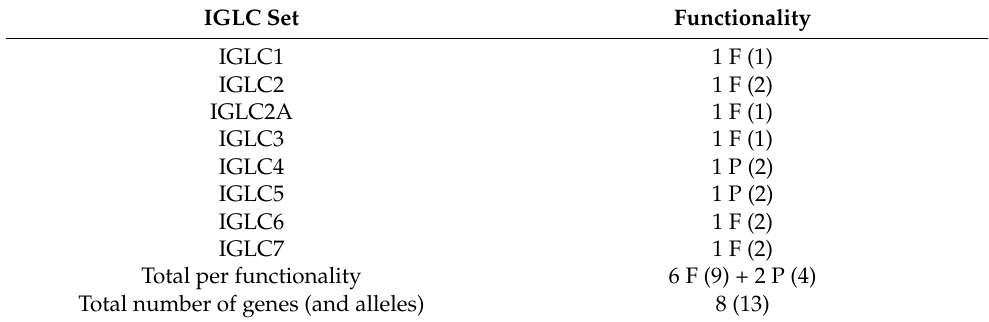
Table 10. Number of IGLC genes per functionality and, between parentheses, number of alleles. IGLC